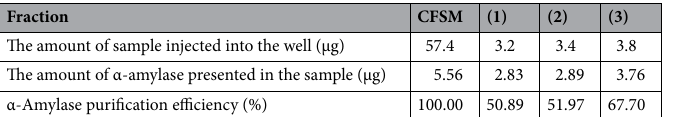
Fraction The amount of sample injected into the well (μg) The amount of α-amylase presented in the sample